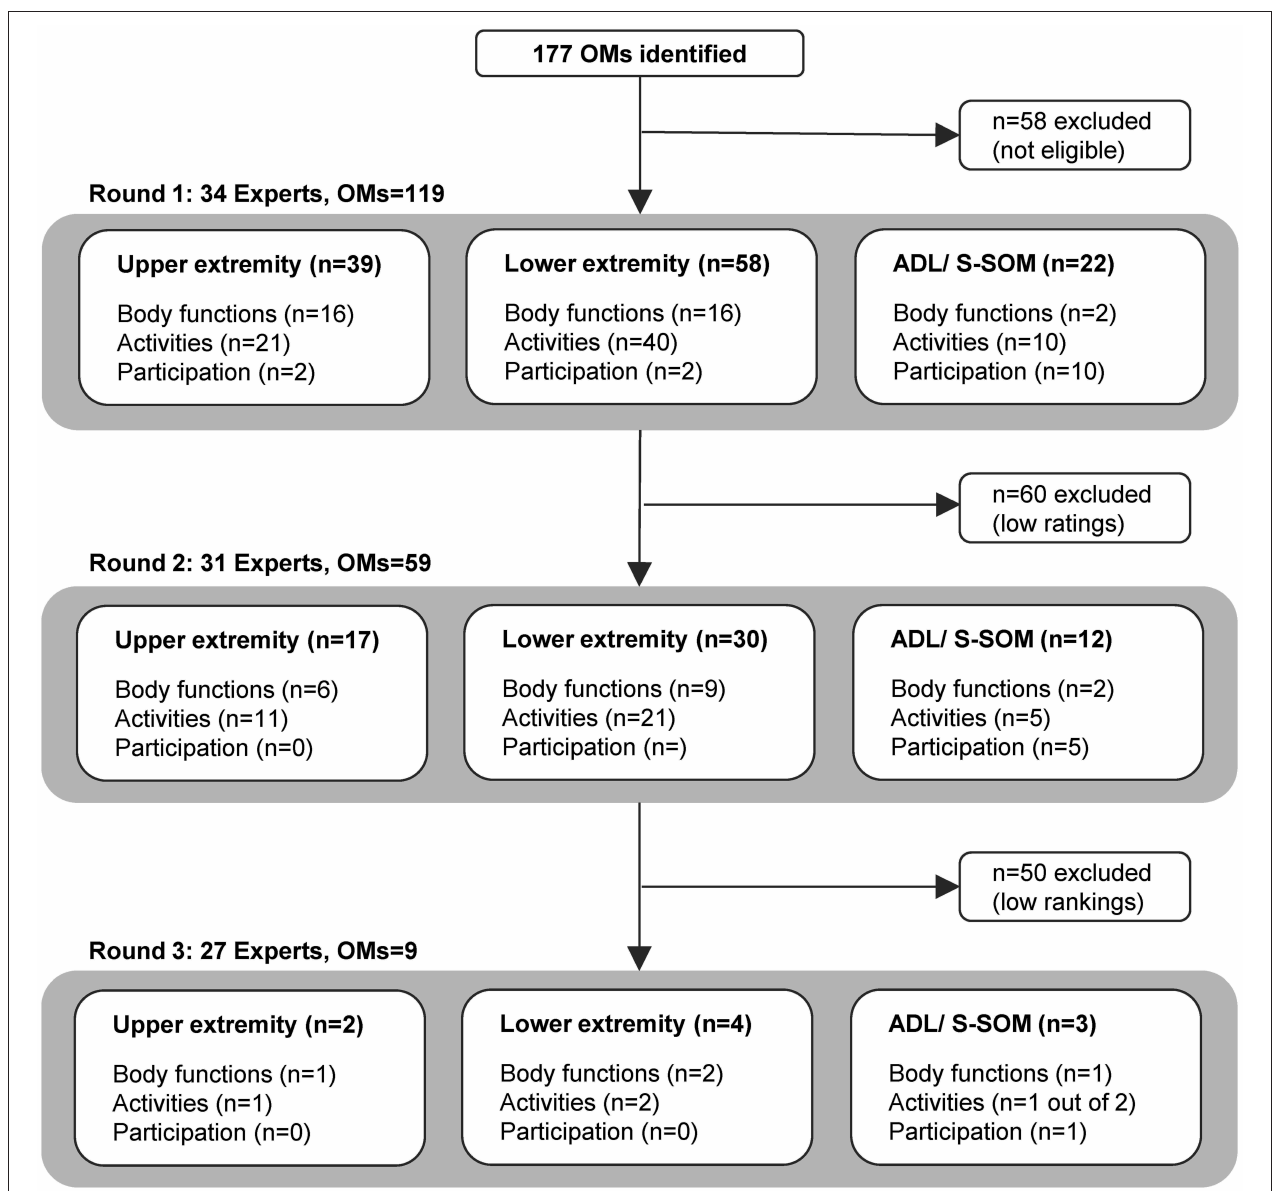
FIGURE 2 | Flowchart of outcome measures per Delphi round, section, and ICF domain. ADL, activities of daily living; ICF , International Classification of Functioning, Disability, and Health ; OMs, outcome